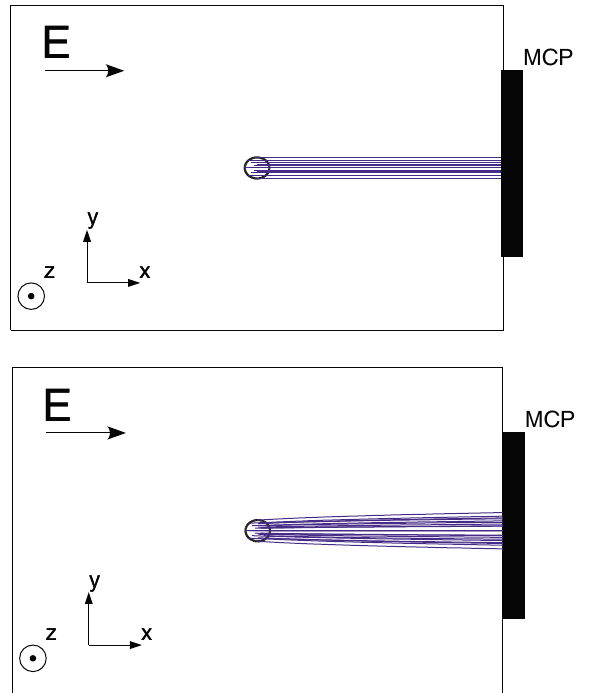
FIG. 1. (Color) Simulated ion trajectories in the IPM. Ions are created by the beam (traveling in the (cid:2) z direction) in the center, then drift toward the MCP. The upper diagram is the idealized case where the field due to the beam is negligible. The lower diagram shows the distortion of the trajectories for realistic beam